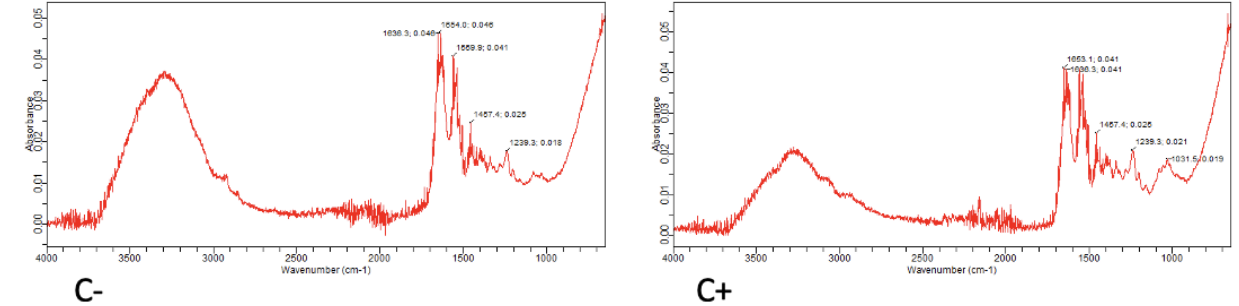
Figure 7. FTIR spectrum of the negative control (C − ), corresponding to demineralized dentin, and positive control (C+), corresponding to healthy dentin.